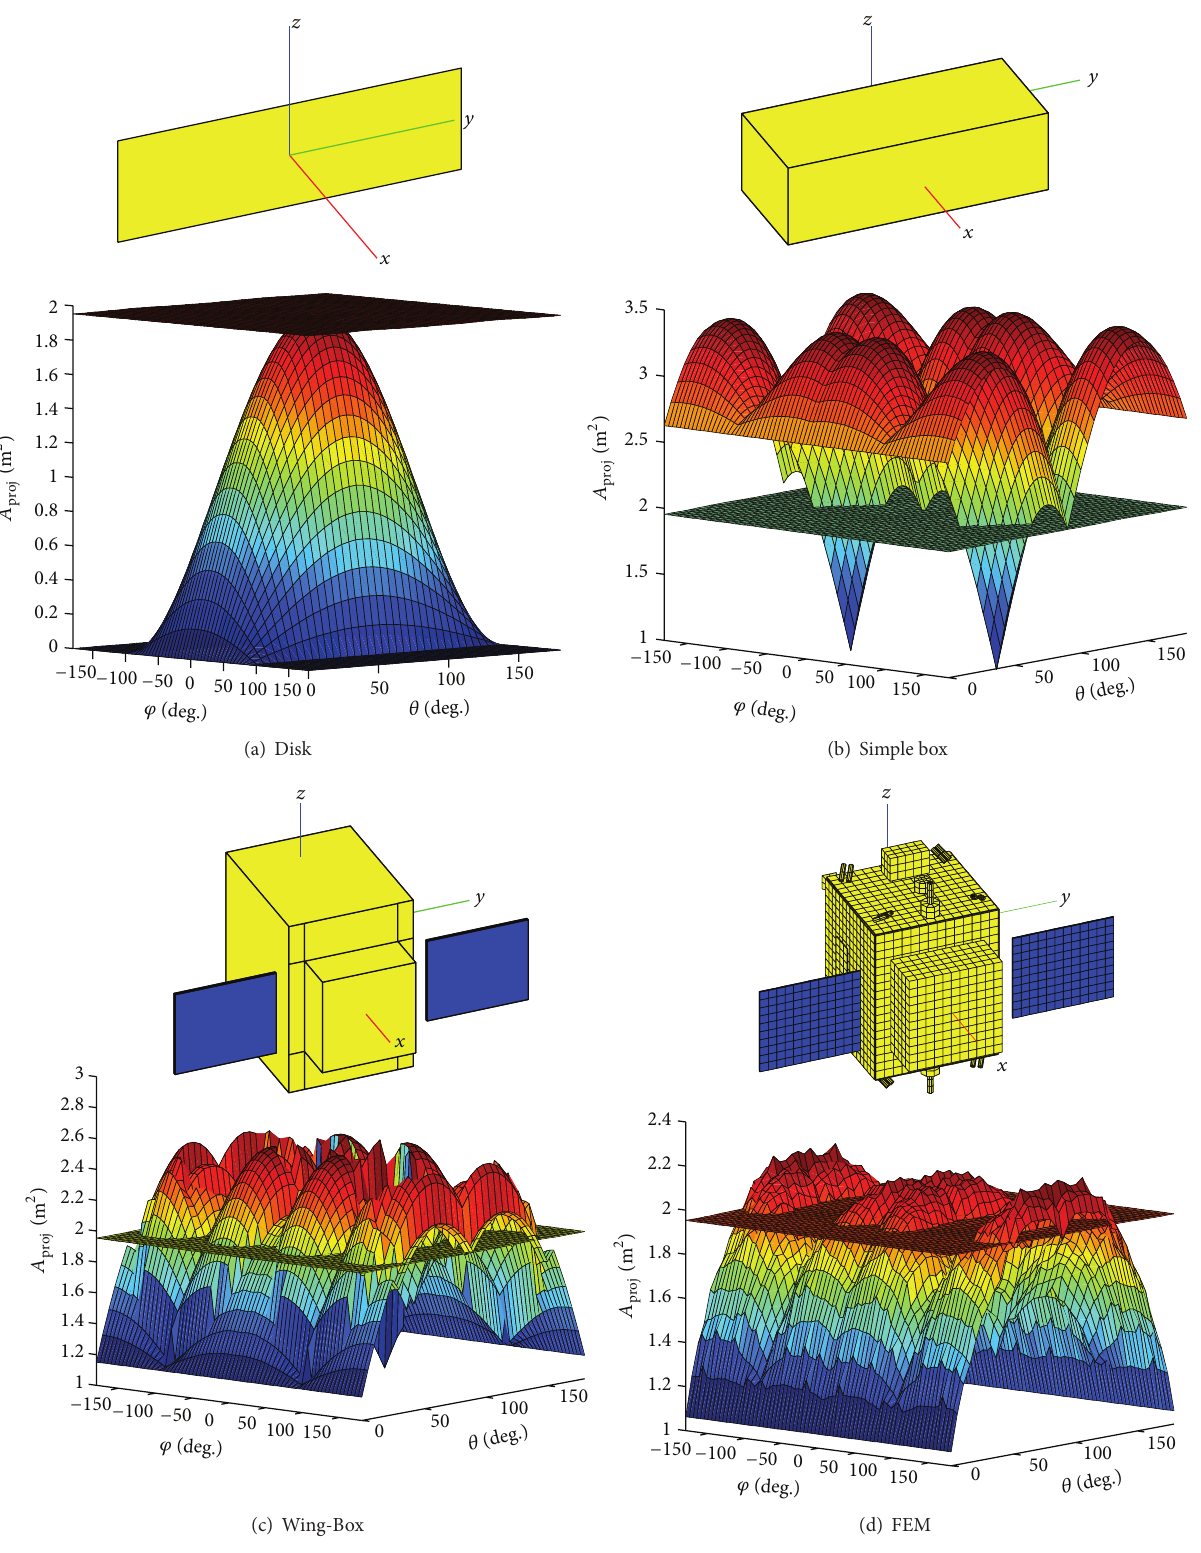
Figure 4: Upper part (a, b, c, and d): different geometry models for the SRP computation with same projected area in 𝑥 -direction. Lower part (a, b, c, and d): projected area ( 𝐴 proj = cos (𝜃)𝐴 ) as function of incident sunray in polar coordinates 𝜑 and 𝜃 for the corresponding models and the sphere model (constant